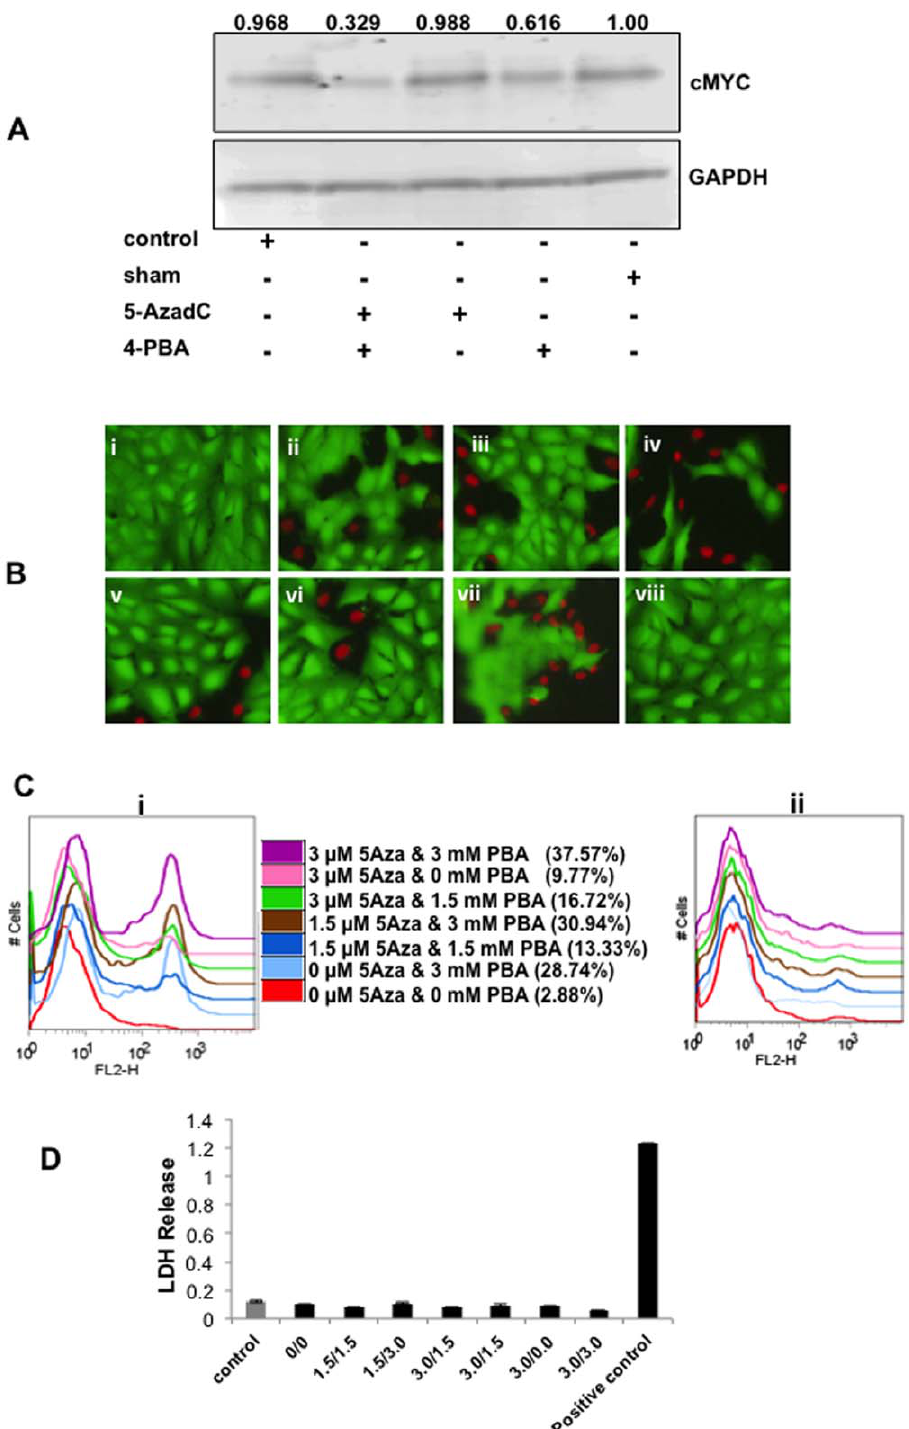
Figure 3. 5-AzadC and 4-PBA induce apoptosis in Saos2 cells. A ) Cells treated with 5-AzadC and 4-PBA alone or in combination along with sham and untreated cells were subjected to western blot analysis using anti-cMYC antibody. The blot was stripped and re-probed with anti-GAPDH antibody. Signal intensity was measured by densitometry analysis using image J software. cMYC/GAPDH ratio of sham treated cells was considered as unity and relative cMYC/GAPDH ratios were calculated (plotted on the top of the blot). The results show that treatment of Saos2 cells with 5-AzadC and 4-PBA decreased endogenous cMYC levels. B ) Cells were treated with 5-AzadC and 4-PBA at concentrations of i) 0 m M & 0 mM; ii) 0 m M & 3 mM; iii) 1.5 m M & 1.5 mM; iv) 1.5 m M & 3 mM; v) 3 m M & 1.5 mM; vi) 3 m M & 0 mM; and vii) 3 m M & 3 mM, respectively. Green and red color staining represents live and dead cells, respectively. C ) FACS analysis of cells treated with 5-AzadC and 4-PBA at various dose combinations led to apoptosis (% given in parenthesis). FACS analysis of cells treated with 5-AzadC and 4-PBA together with Z-VAD-fmk, which led to a significant reduction in the apoptosis of treated cells shown on the right panel. D ) Cytotoxicty assay in 5-Aza and 4-PBA treated Saos2 cells with untreated (control) and sham treated (0/0) controls. Maximum LDH release from equal number of sham treated cells grown under identical condition is shown as positive control. doi:10.1371/journal.pone.0043720.g003 PLOS ONE |